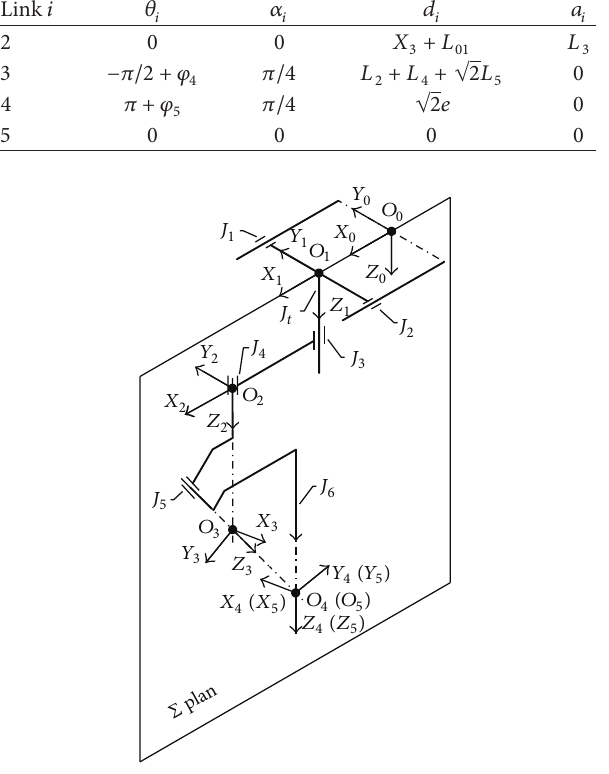
Figure 2: Denavit-Hartenberg reference